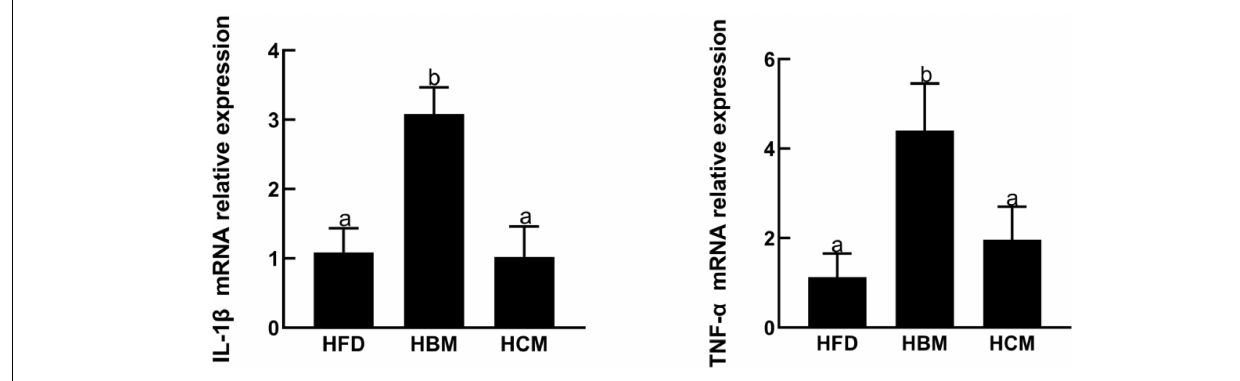
FIGURE 5 | Effects of buffalo and cow milk on expression level of genes related to pro-inflammation responses in mice fed by high fat diet.